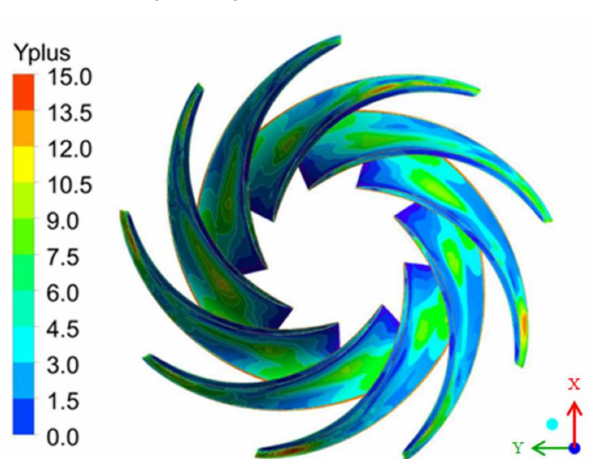
Figure 4. Local grid diagram.